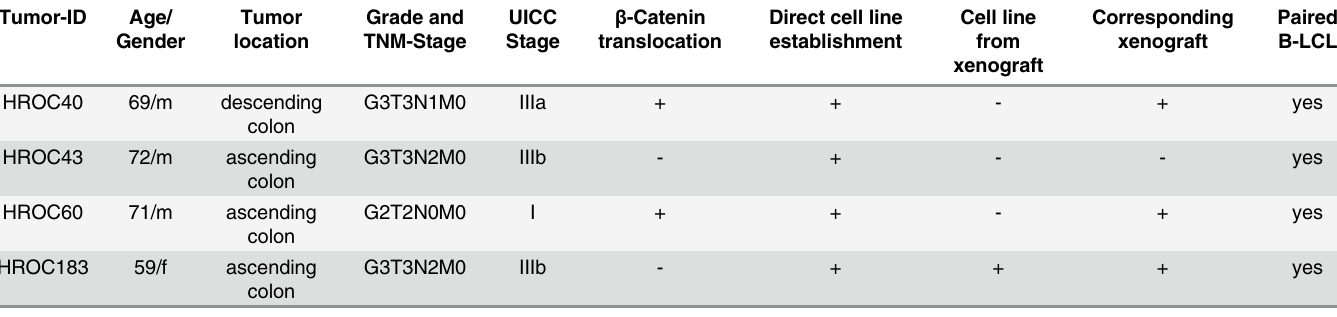
Table 1. Clinical and pathological characteristics of patients as well as cell line establishment protocol. Tumor-ID Age/